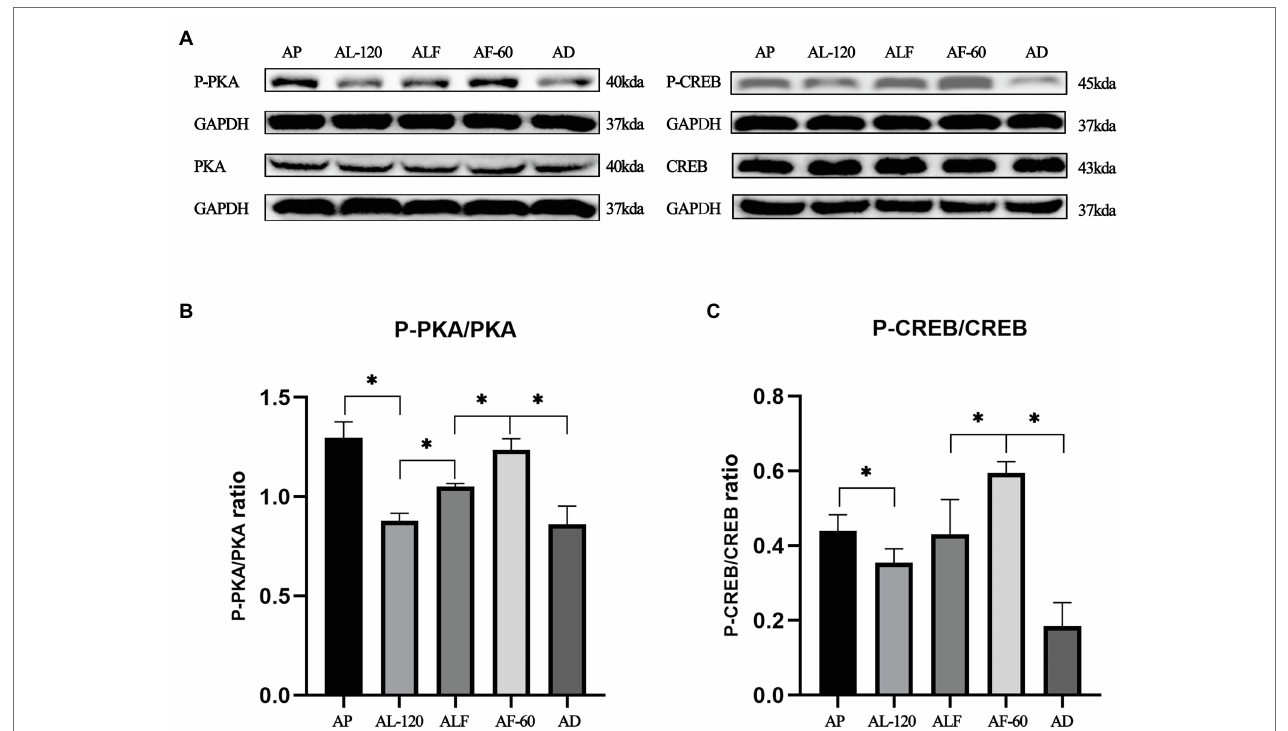
FIGURE 4 | The blocking effects of acute forskolin treatment on acute lactate injection induced inhibition of cAMP-PKA pathway. (A) Western blot analysis of cAMP-PKA pathway proteins after acute lactate and forskolin injections. (B) The ratios of P-PKA/PKA after acute lactate and forskolin injection. (C) The ratios of P-CREB/CREB after acute lactate and forskolin injection. AP and AD mean sacrificed after acute PBS and DMSO injection, respectively. ALF means sacrificed at 60 min after acute lactate and forskolin injection (60 min interval). AL-120: sacrificed 120 min after acute lactate injection. AF-60: sacrificed 60 min after acute forskolin injection. Three bands are used for statistics. The data are presented as the mean ± SD, and significant differences among the groups were analyzed with one-way ANOVA. * p <